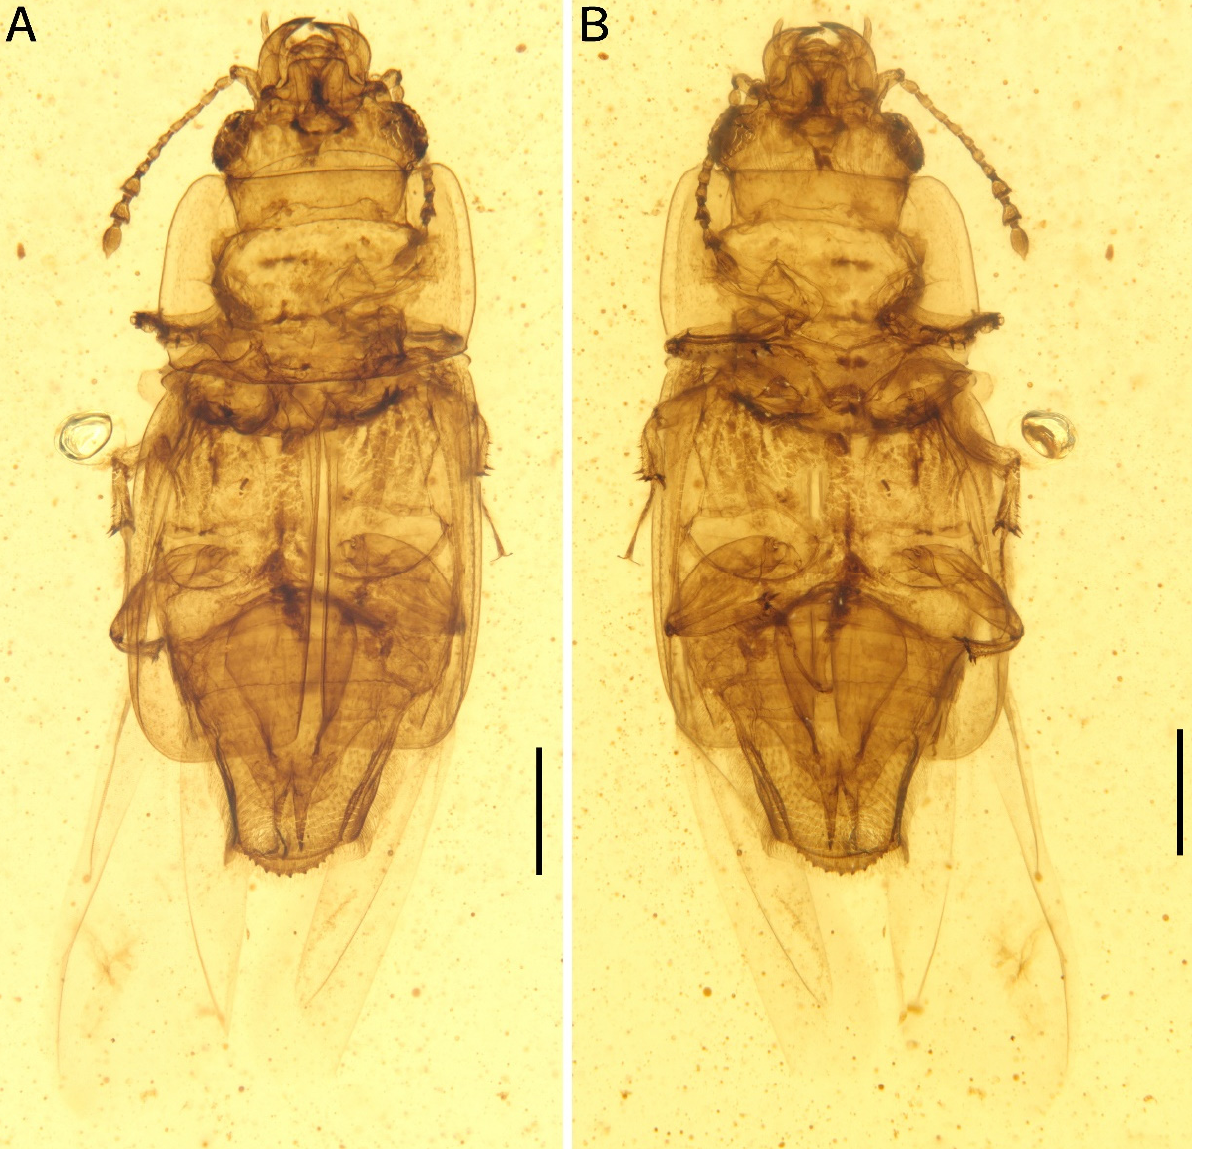
Figure 1. Photomicrographs of Protonitidula neli gen. et sp. nov. from mid-Cretaceous Burmese amber under normal reflected light (holotype, NIGP200399). Note that the well-developed hind wings are exposed. ( A ) dorsal view. ( B ) ventral view. Scale bars, 500 μ m.